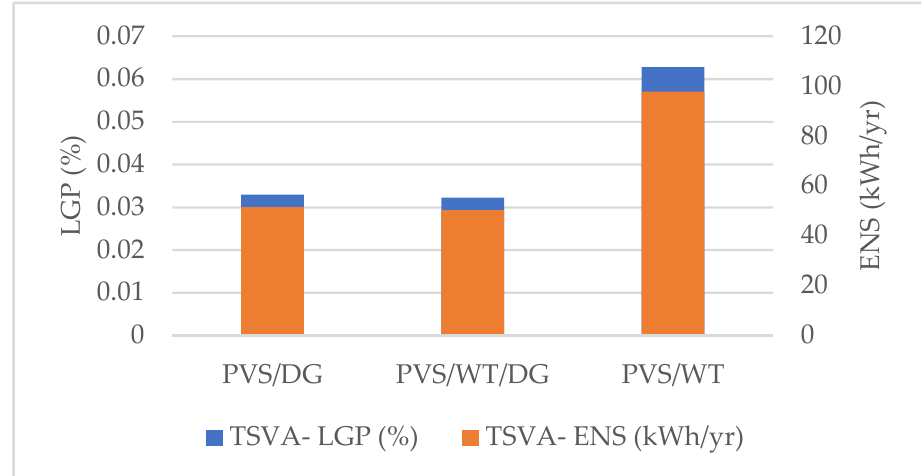
Figure 10. Reliability indices for TSVA used in various configurations.